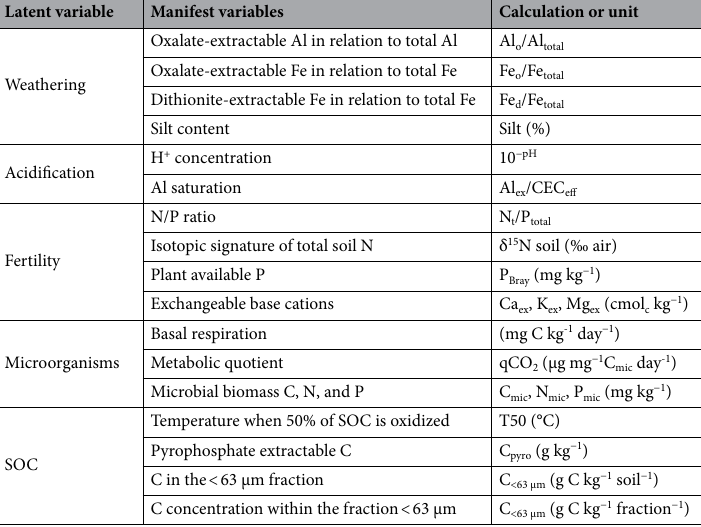
Table 1. Description of the composition of the latent